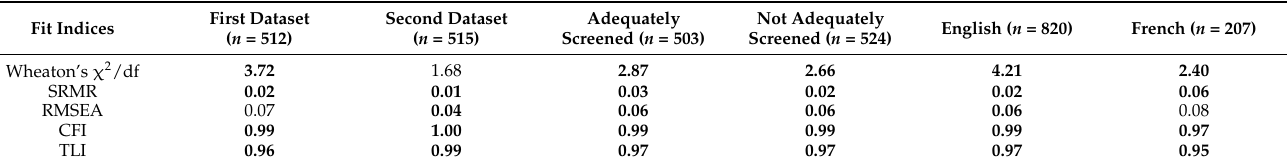
Table 6. CFA model fit indices for the HPV Self-Sampling Attitudes and Beliefs Scale (7